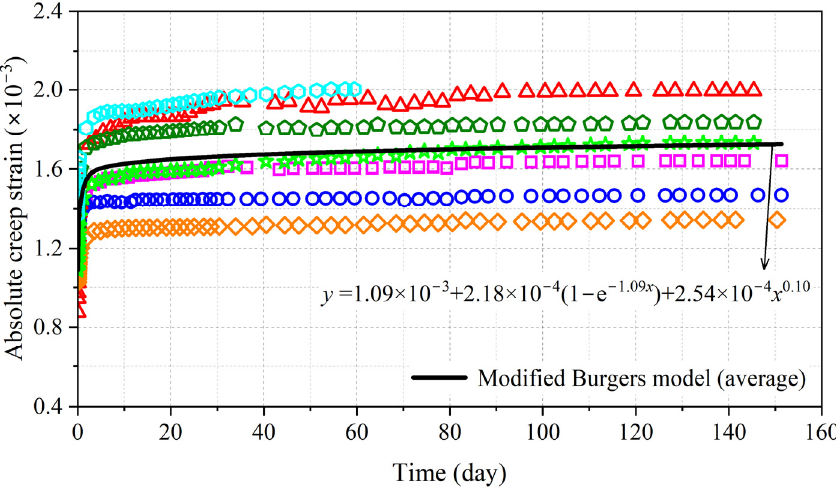
Figure 10. Fitting results by modified Burgers model.